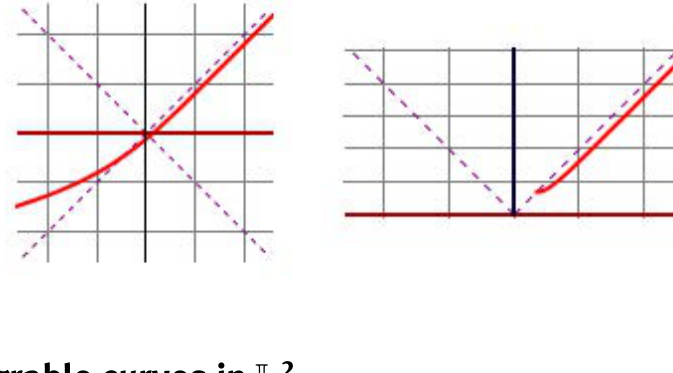
Fig. 17. Timelike curves with K( y ) = e y + 1 (left) and K( y ) = e y − 1